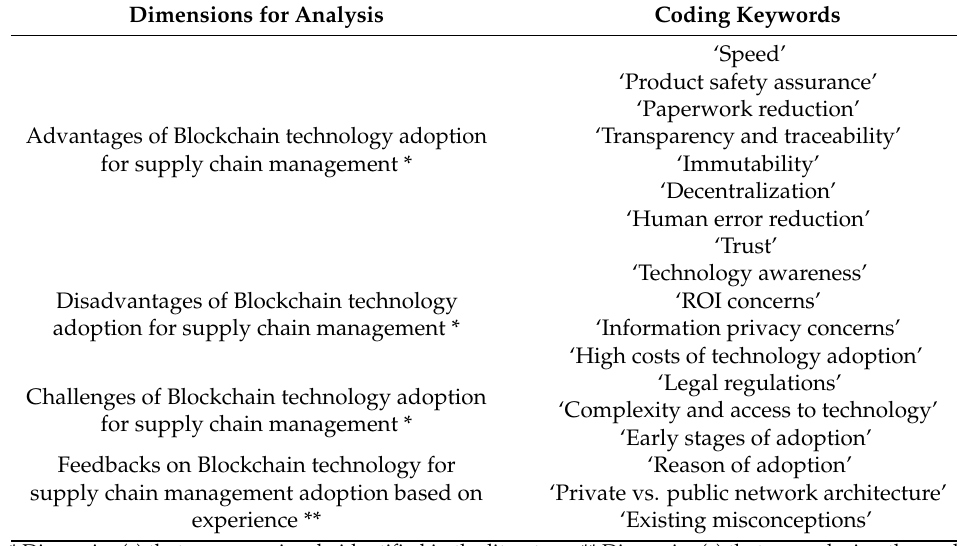
Table 3. Dimensions for data analysis and the coding keywords used. Dimensions for